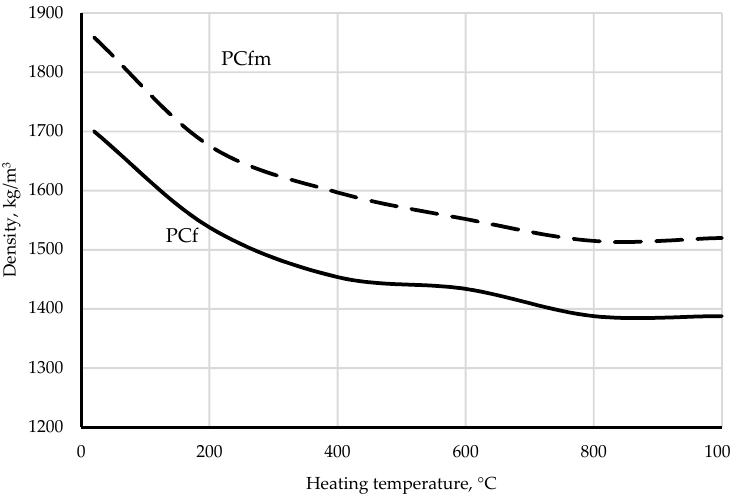
Figure 5. Change in density of PCf and PCfm concretes.